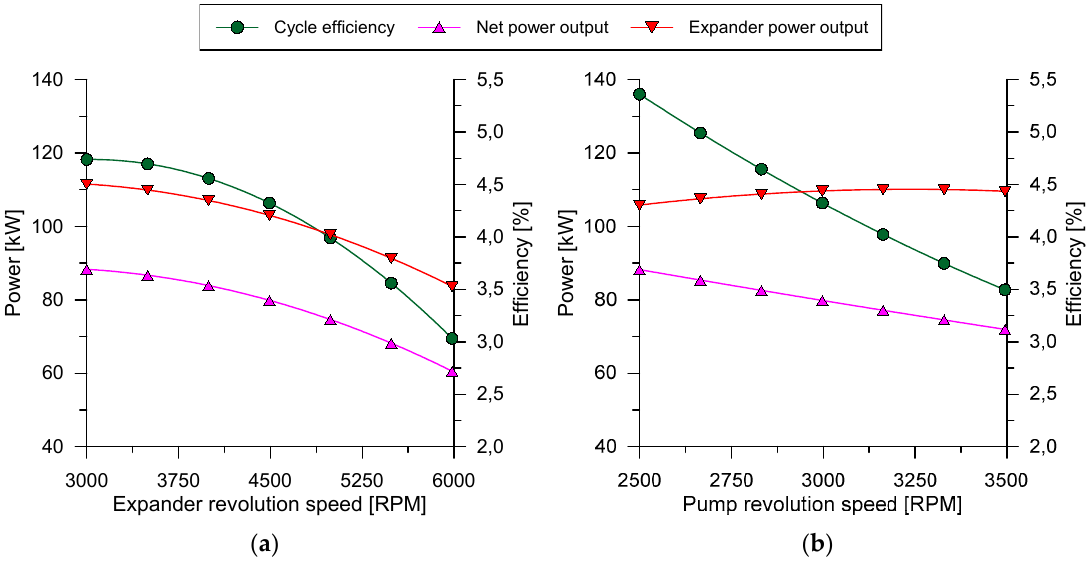
Figure 10. Results of the system and expander performance in on and off-design conditions varying: ( a ) the expander revolution speed and ( b ) the pump revolution speed. Designs 2018 , 2 , x FOR PEER REVIEW